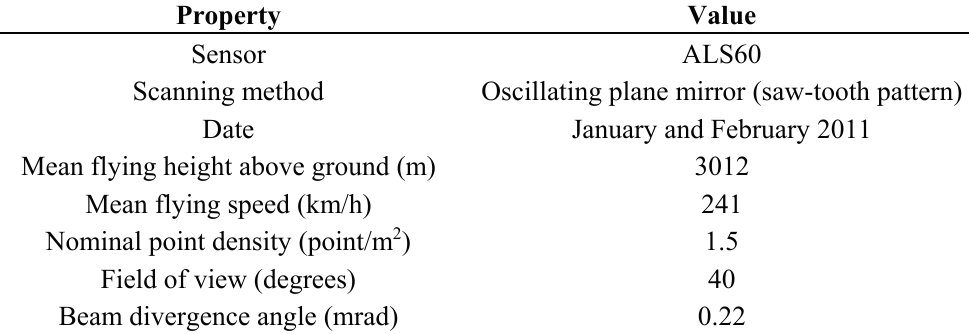
Table 1. Airborne laser scanning (ALS) data specifications and acquisition